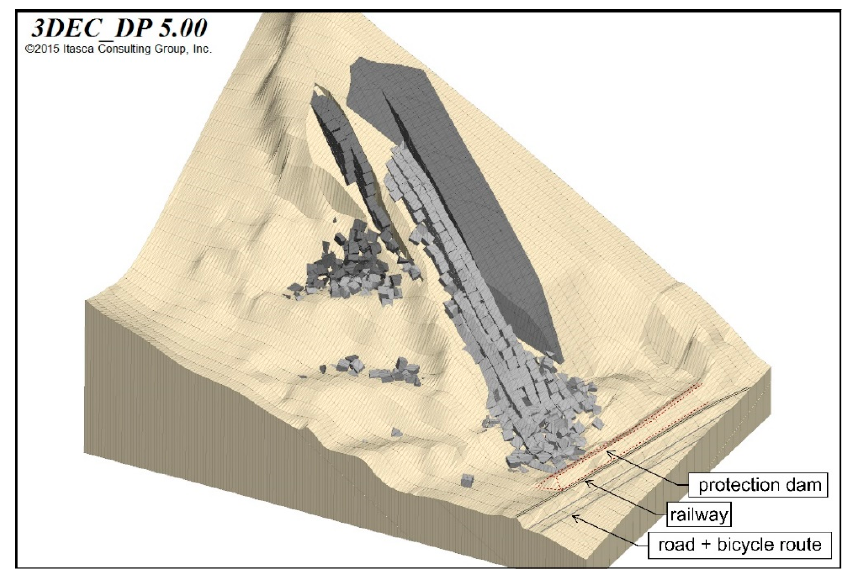
Figure 9. The final state of 3DEC simulation of Scenario 1.